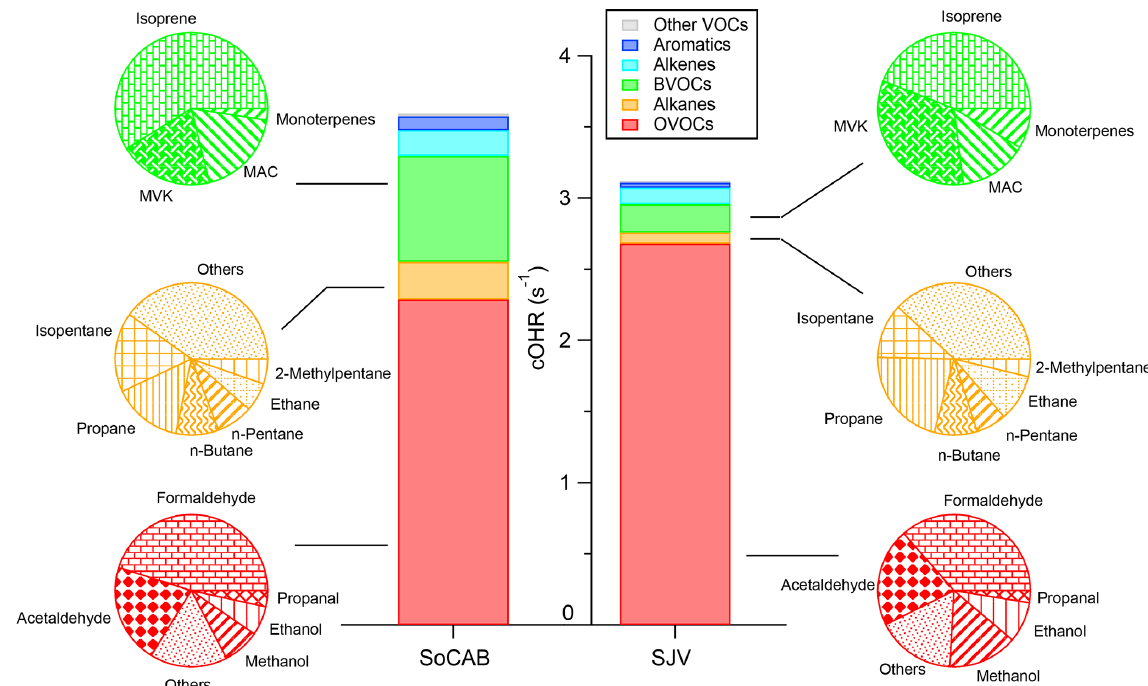
Figure 5. The measured cOHR of VOCs in the SoCAB and SJV.